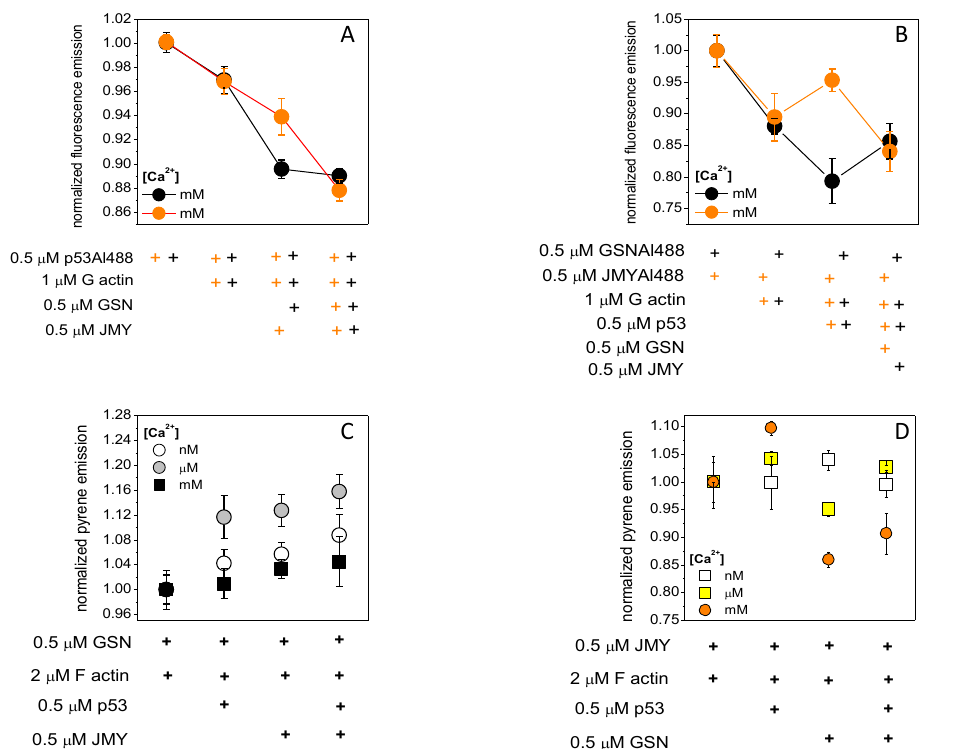
Figure 3. Actin competes with p53 on JMY and p53 competes with actin on GSN in a calcium- dependent manner. ( A ) The emission of 0.5 µ M p53Alexa488 was reduced by 3% by 1 µ M actin then 3% or 10% more by subsequently adding 0.5 µ M JMY (orange circles) or 0.5 µ M GSN (black circles), respectively, in the absence of polymerizing salts (100 mM KCl, 1 mM MgCl 2 ) and in the presence of 1 mM Ca 2+ . The emission was not changed by the addition of JMY in the presence of actin and GSN, but it was reduced by 7% by GSN in the presence of actin and JMY (orange plus belongs to orange circle, black plus belongs to black circle). ( B ) The fluorescence emission of 0.5 µ M JMYAlexa488 (orange circles) was reduced by 11% by 1 µ M actin then increased by 5% by subsequently adding 0.5 µ M p53 in the absence of polymerizing salts and in the presence of 1 mM Ca 2+ . The fluorescence emission of 0.5 µ M GSNAlexa488 (black circles) was reduced by 13% by actin then decreased 10% more by subsequently adding p53. The emission of JMYAlexa488 was reduced by 12% by 0.5 µ M GSN in the presence of actin and p53; in addition, the emission of GSNAlexa488 was increased by 8% by 0.5 µ M JMY in the presence of actin and p53. ( C ) Pyrene–actin (2 µ M, 5% labeled by pyrene) was polymerized (100 mM KCl, 1 mM MgCl 2 ) in the presence of 0.5 µ M GSN. The fluorescence emission of pyrene was increased by 0.5 µ M p53 then subsequent 0.5 µ M JMY addition in the presence